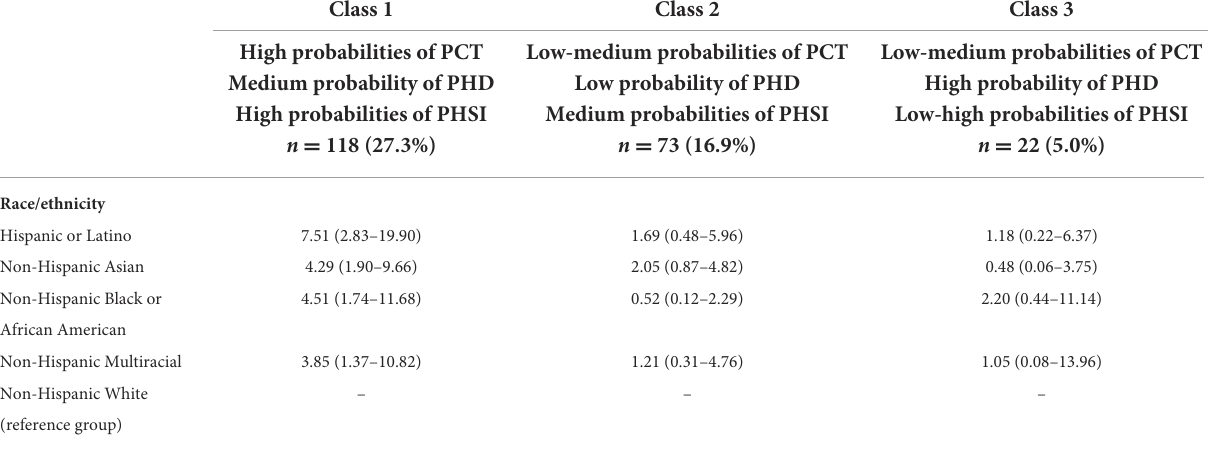
TABLE 3 Racial/ethnic differences in latent class